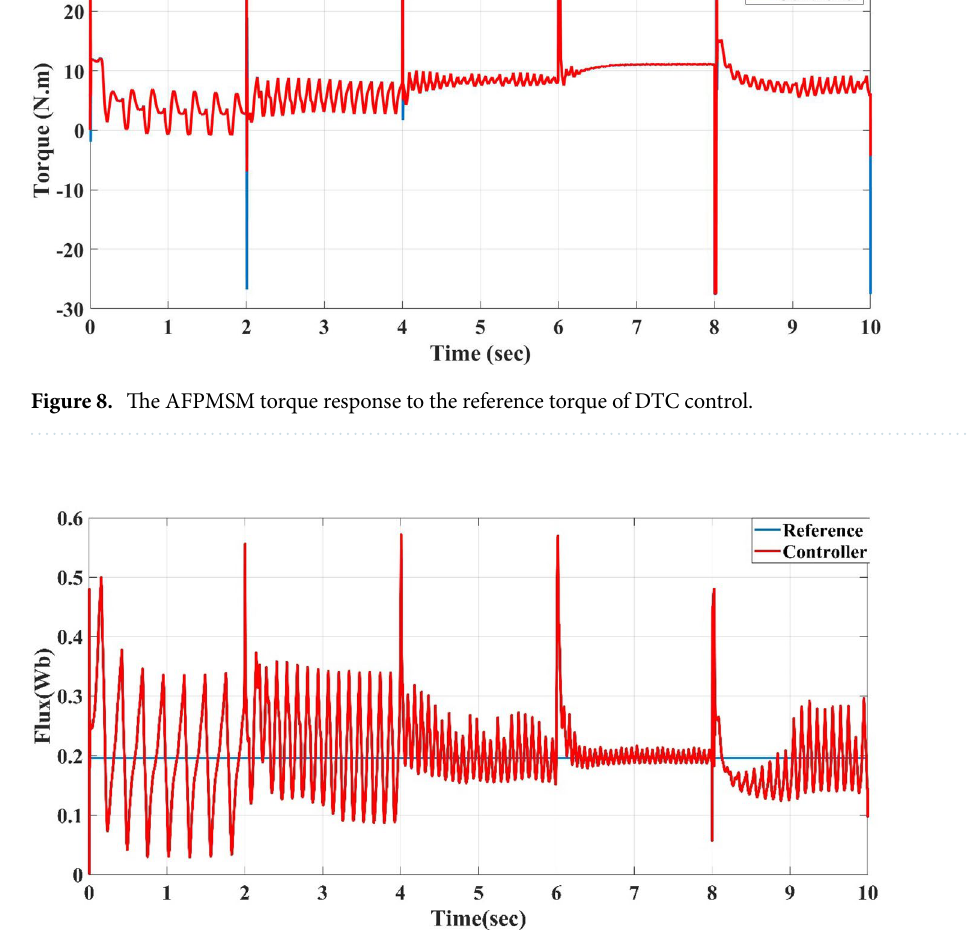
Figure 9. The AFPMSM flux response to the reference flux of DTC